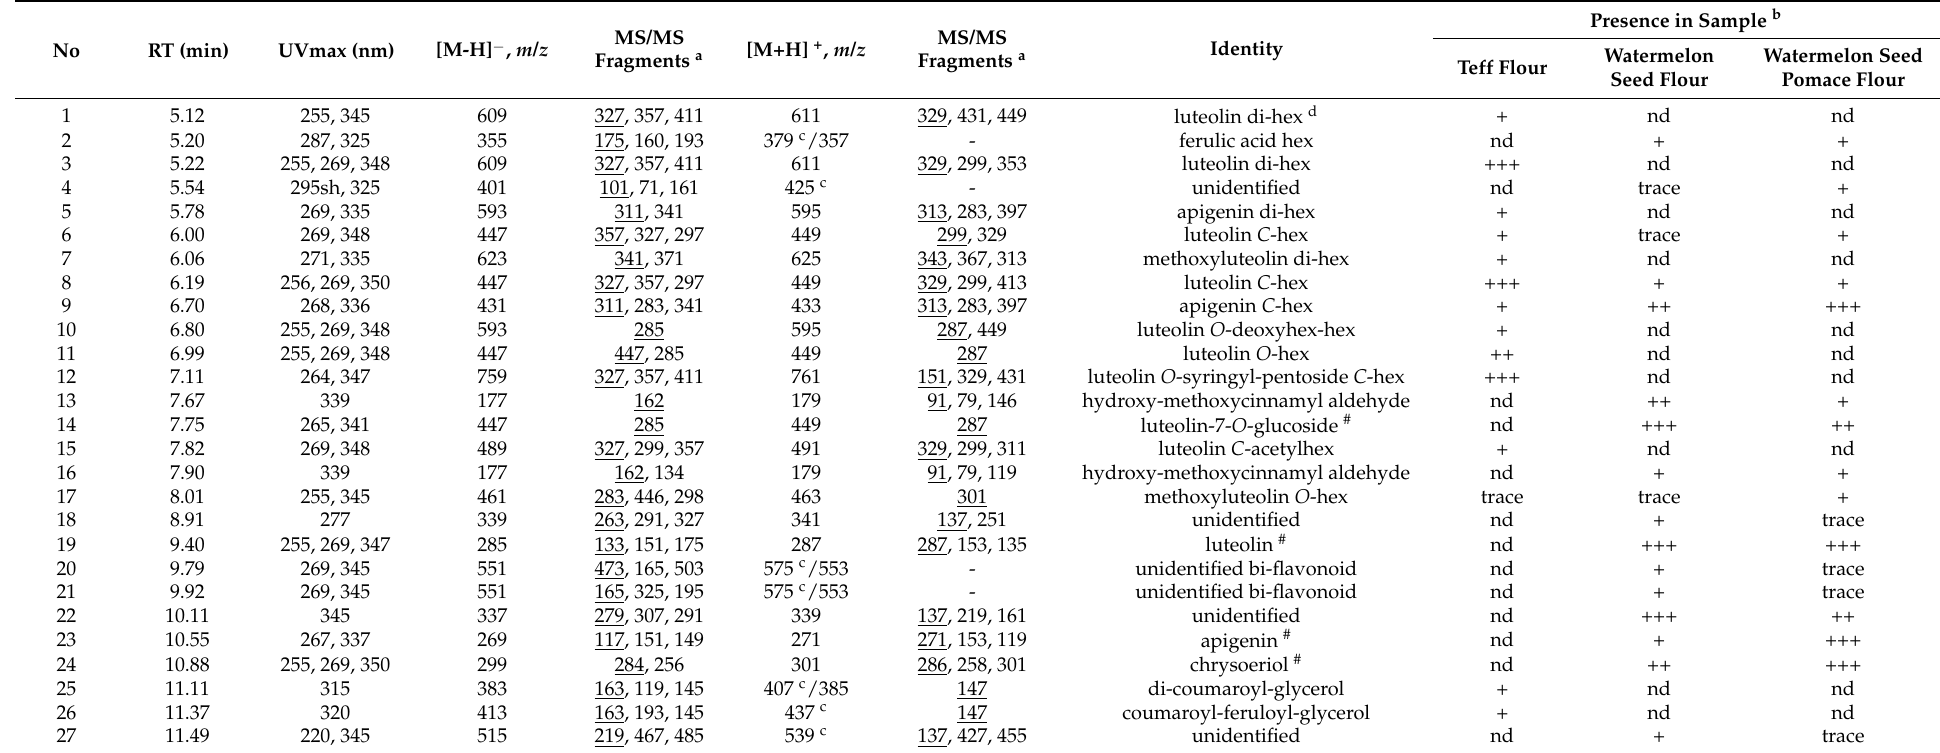
Table 2. Phytochemical screening of teff and watermelon flour samples based on UHPLC-PDA-ESI-MS/MS